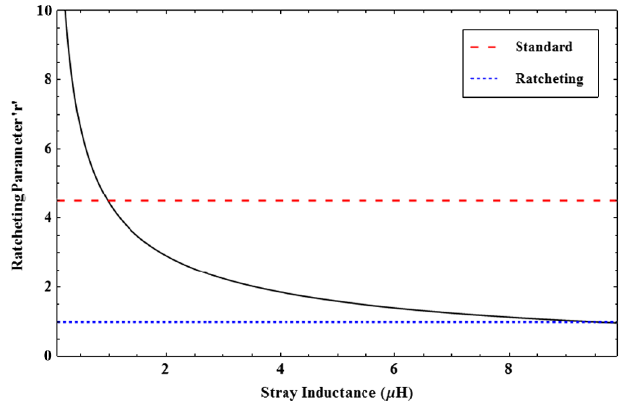
FIG. 3. The achievable ratcheting parameter r is plotted for the ferrite Phillips 4L2 using fitting data collected at BNL